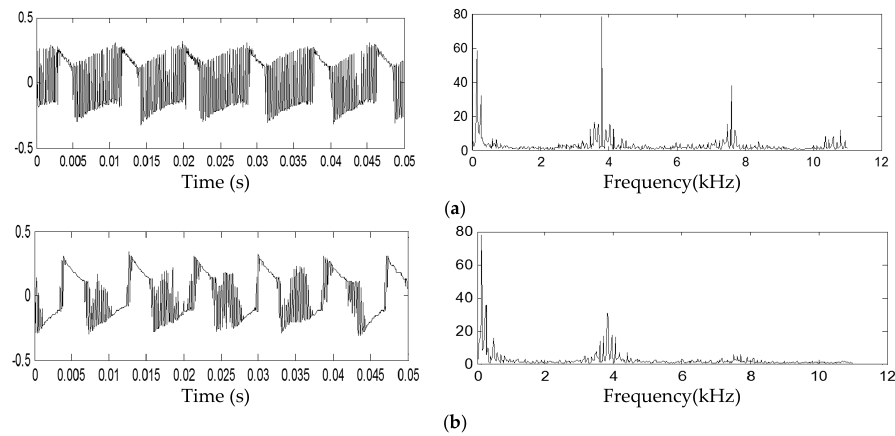
Figure 8. Tested results of self-excited noise inside the servovalve. ( a ) The tested noise wave and FFT analysis results without magnetic fluids; ( b ) the tested noise wave and FFT analysis results with magnetic fluids.